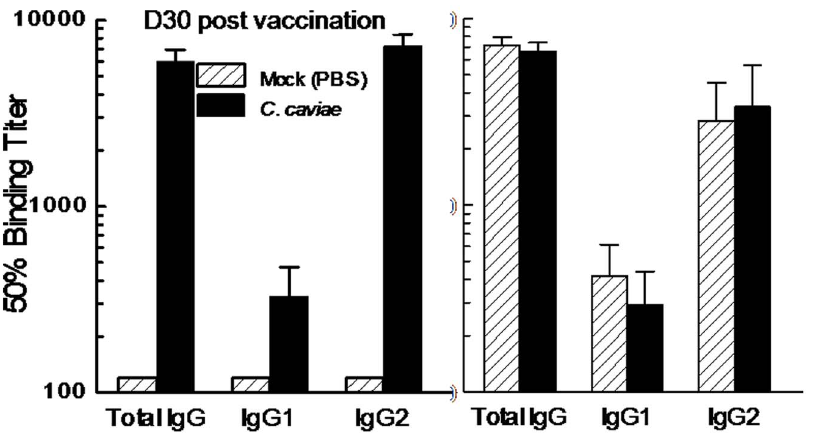
Fig. 2. Intranasal Vaccination with C. caviae Induced Robust Humoral Responses. Groups (5 per group) of guinea pigs were immunized i.n. with 1 6 10 5 IFU C. caviae or treated with PBS as mock vaccination controls. All animals were rested for 30 days and challenged i.vag. with 1 6 10 5 IFU C. caviae . Serum antibody titer (total antibody, IgG1 and IgG2a) to UV-inactivated C. caviae was determined at day 30 post vaccination (A) or at day 15 after challenge (B). Total Ig, IgG1 and IgG2a antibody titers were significantly ( p , 0.05) elevated in C. caviae EB vaccinated guinea pigs compared to mock vaccinated animals prior to challenge (A), but not after challenge (B).